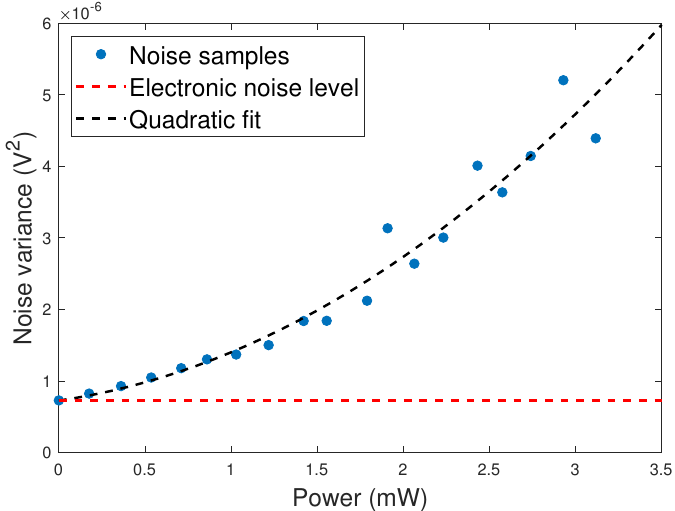
Figure 4. Voltage variance as a function of the LO optical power at the BS input port. Each variance was evaluated over 15.625 × 10 7 noise samples.